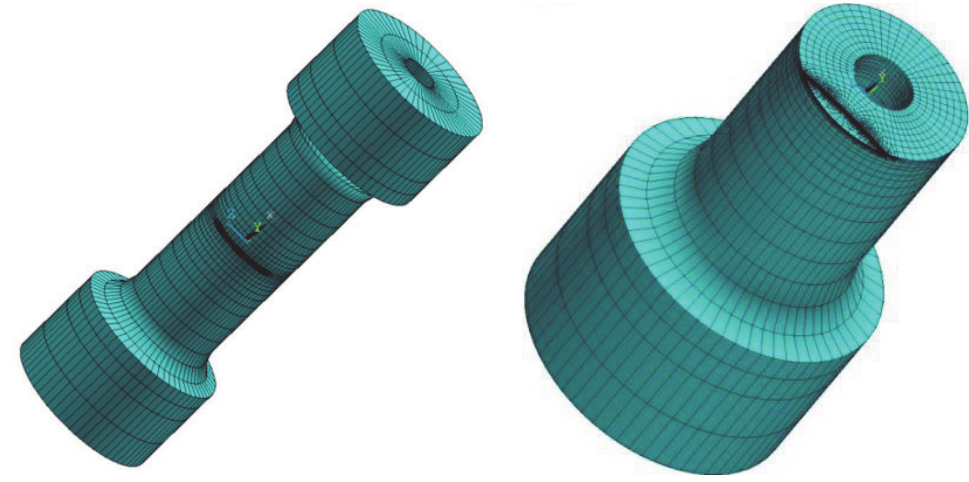
Figure 6: Typical FEM-mesh for cylindrical hollow specimens with semi-elliptical surface crack.